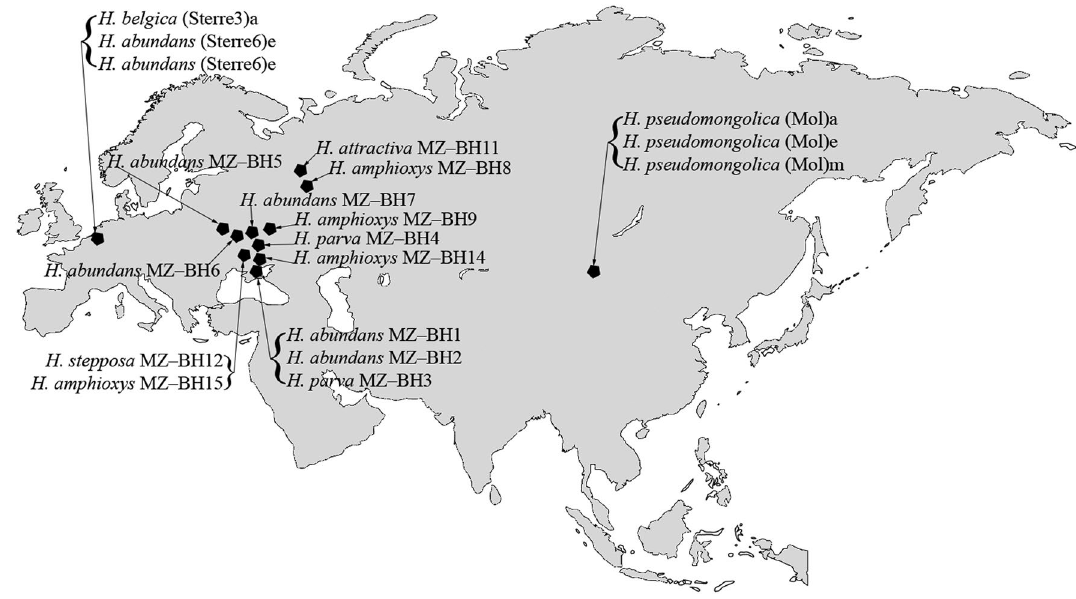
Figure 1. Map with the habitat locations of the studied